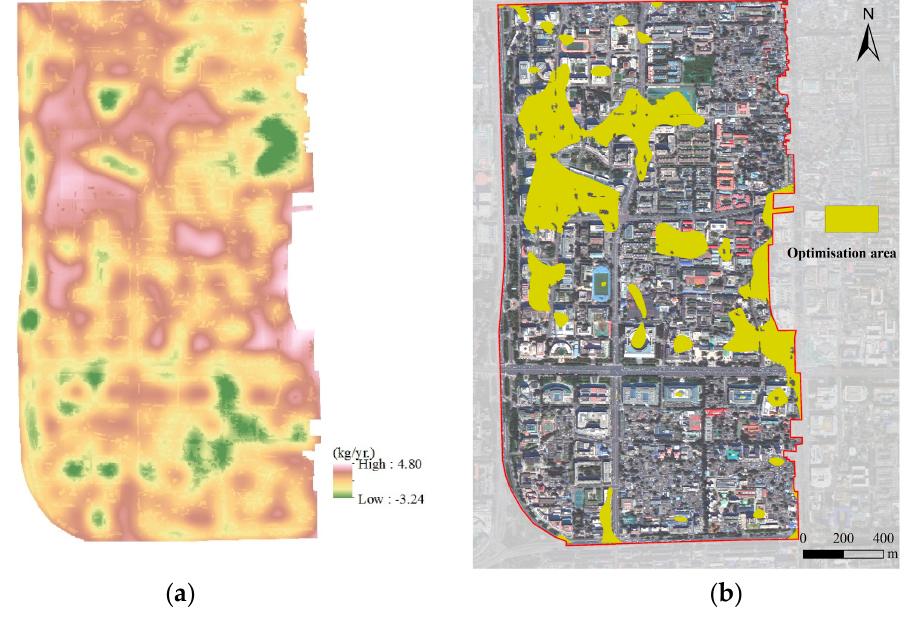
Figure 11. Maps of ( a ) carbon sequestration budgets and ( b ) UGS optimization area in the Jinrongjie sub-district, Beijing.